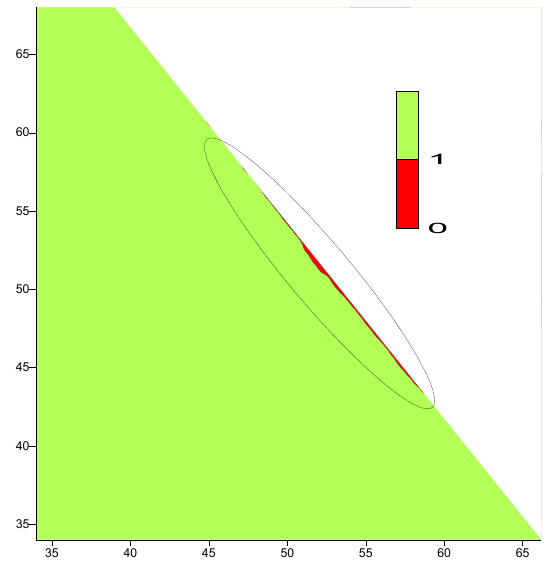
Figure 10. Crack index distribution over the dam body.